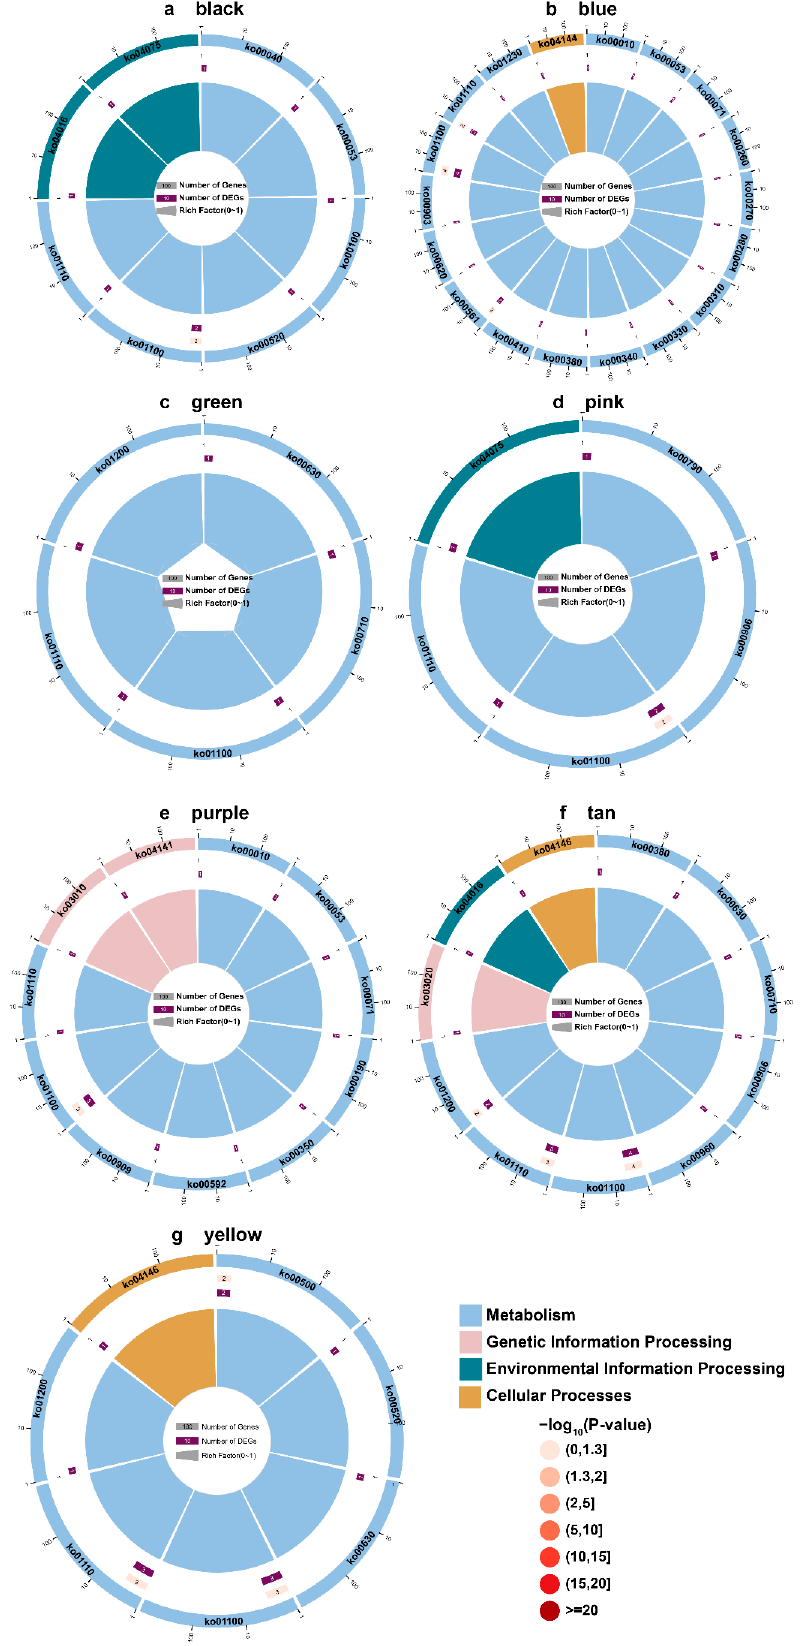
Figure 9. KEGG enrichment analysis of the 7 modules with high correlation. Different colors represent different categories.